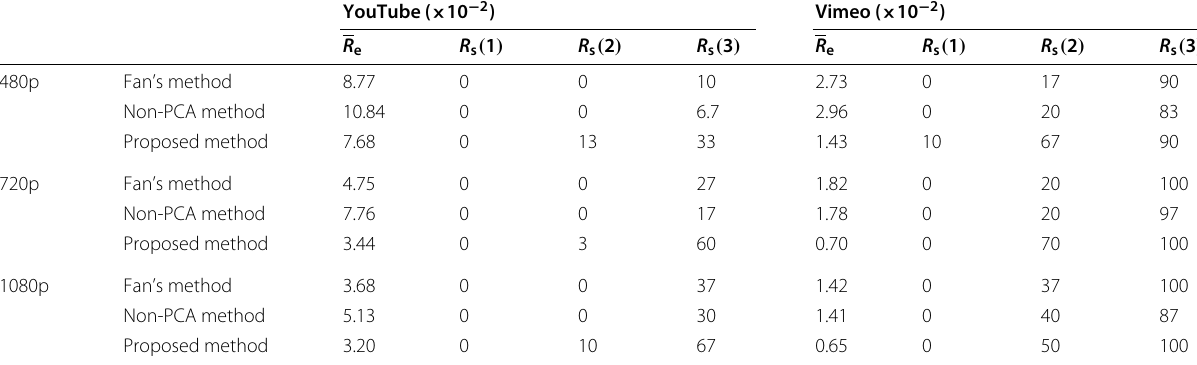
Table 5 The average BER R e and successful extraction rate R s after videos are transcoded by YouTube or